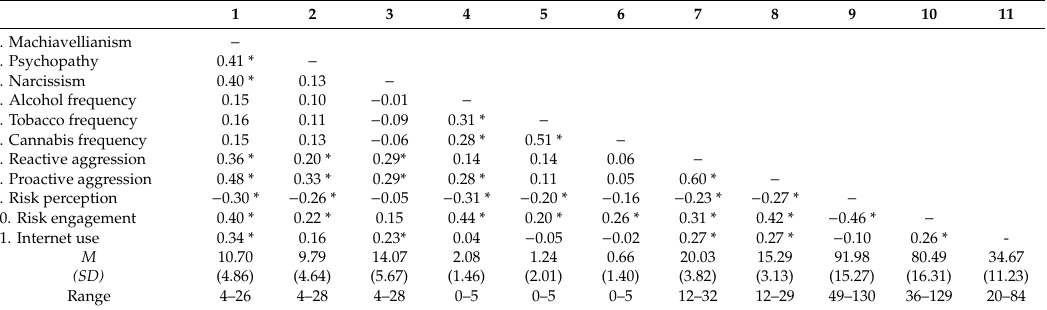
Table 1. Descriptive statistics and partial correlations among all the study variables controlling for gender and age.